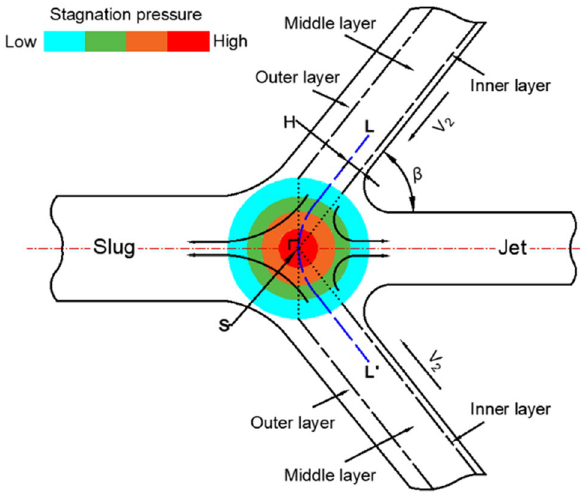
Figure 16. Schematic of particle motion.